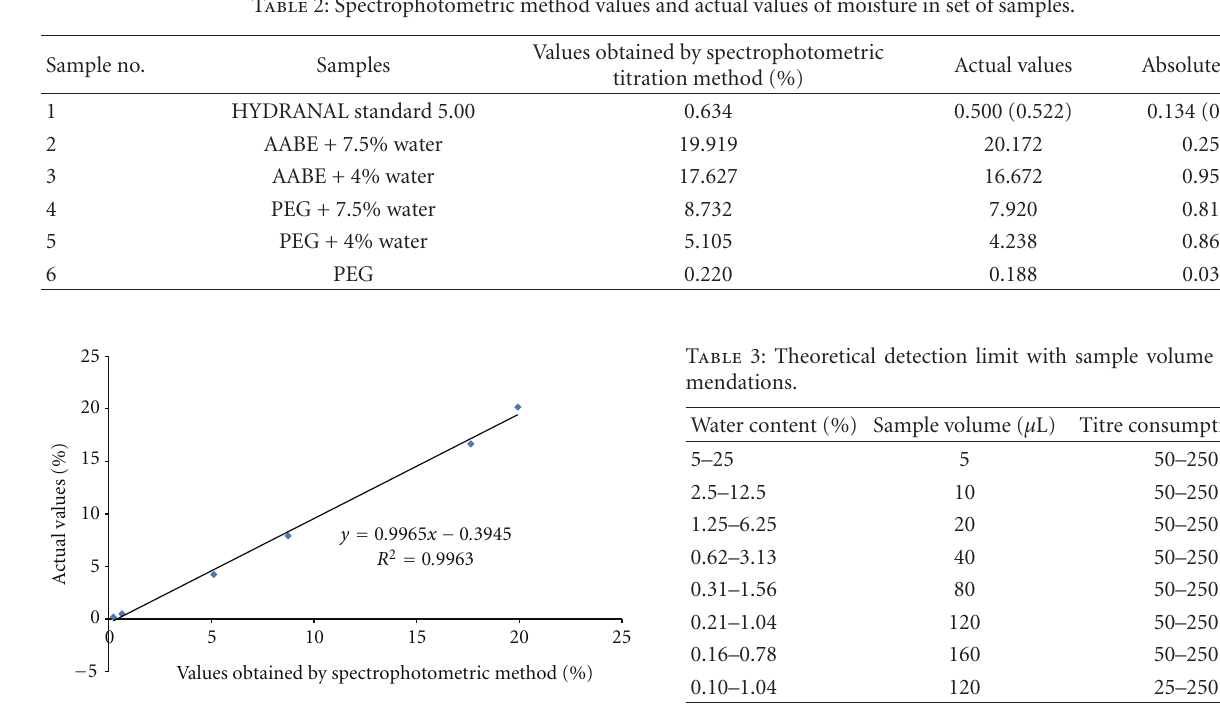
Figure 2: Spectrophotometric method values plotted against actual values of moisture.